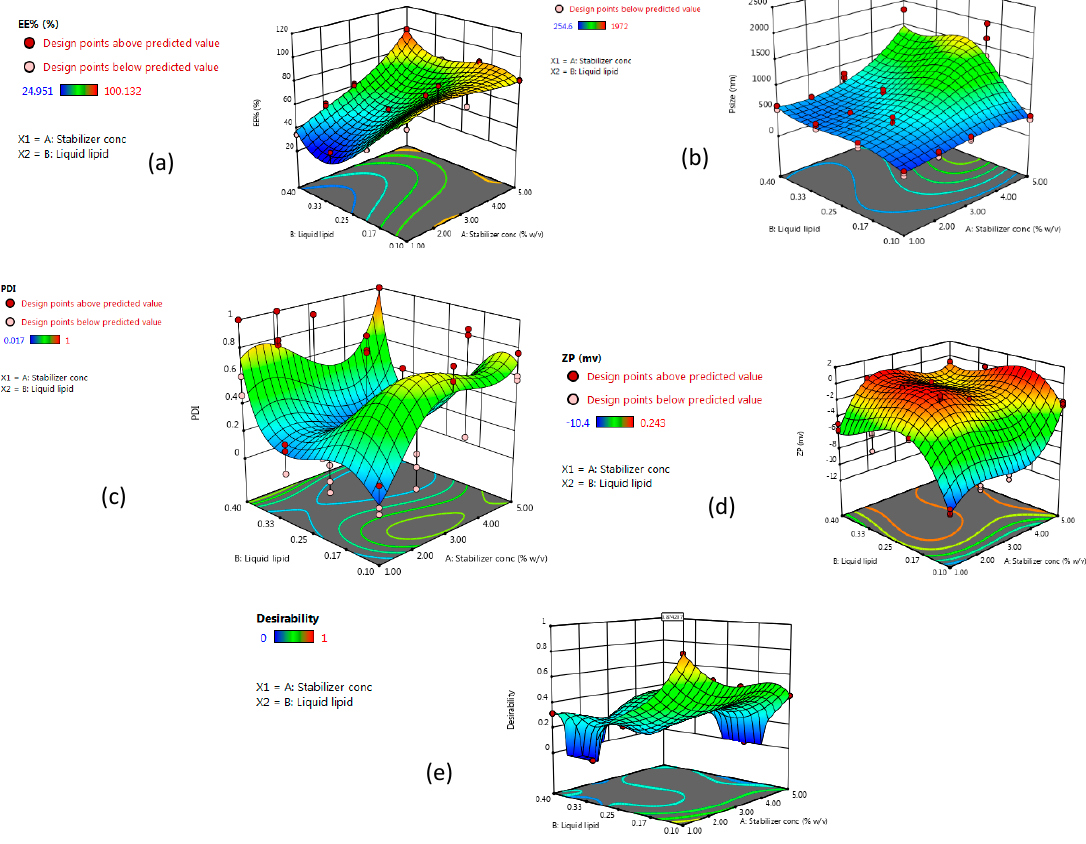
Figure 2. Three-dimensional response surface plots, showing the effect of stabilizer concentration (A) and liquid lipid type (B) on ( a ) EE%, ( b ) particle size, ( c ) polydispersity index (PDI), ( d ) zeta potential, and ( e ) desirability of the prepared nanostructured lipid carrier (NLC) formulations.